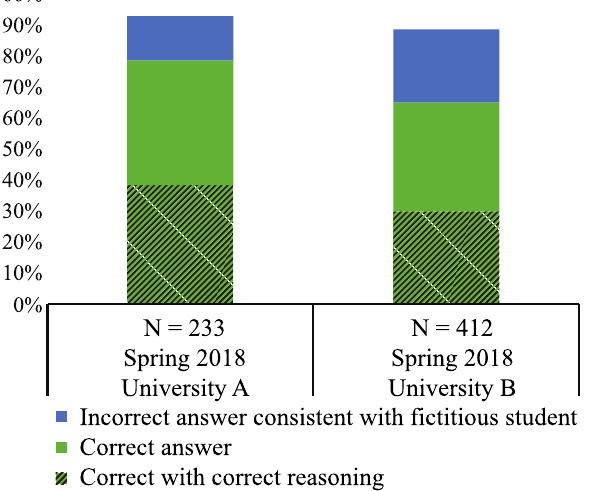
FIG. 8. Student responses on the magnetic induction base task. Shaded areas represent correct answers supported with correct reasoning. All other regions represent answers only, irrespective of the reasoning given. Totals do not sum to 100% because answer choices not aligned with one of the fictitious students are not included.